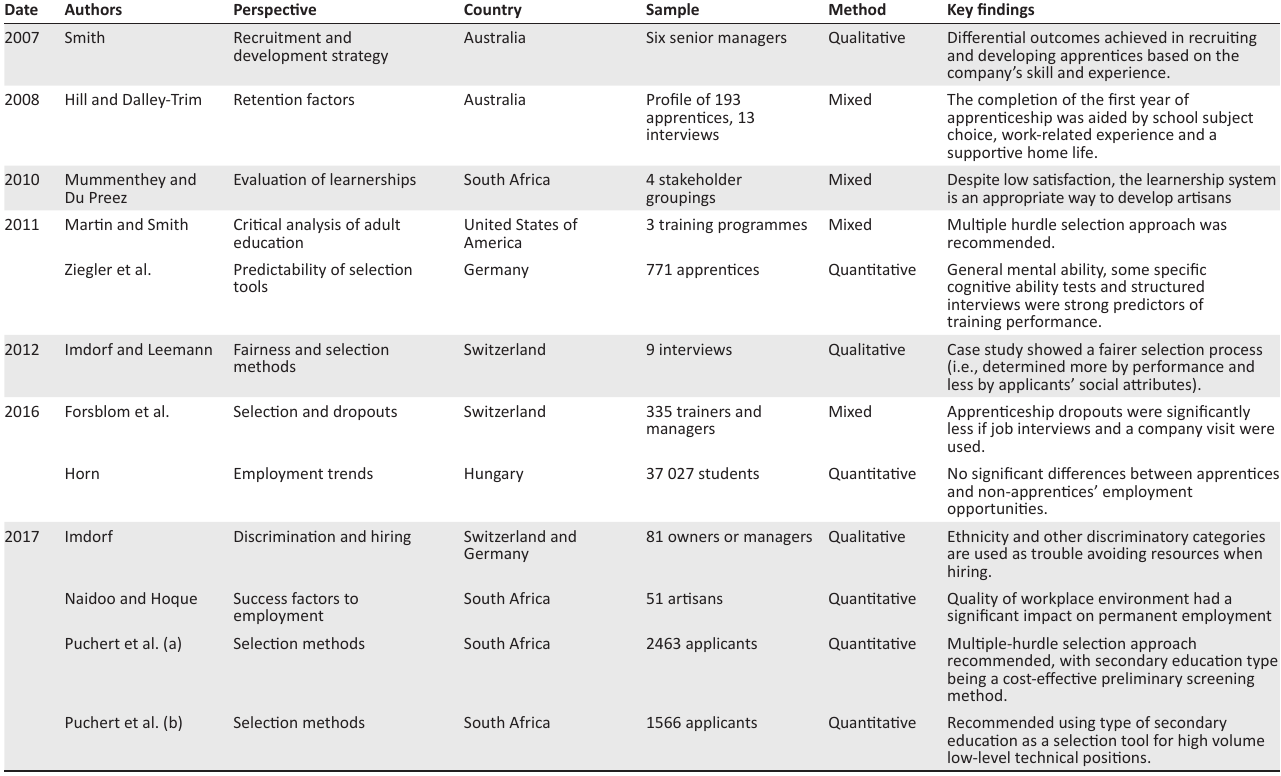
TABLE 5: Descriptive analysis of final systematic literature review